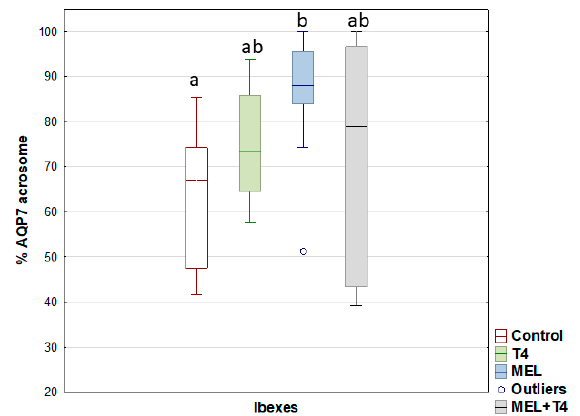
Figure 5. AQP7 expression by immunocytochemistry labelling (ICC) in acrosome of ibex sperm (controls (red); treated with thyroxine (T4, green); treated with melatonin implants (MEL, blue); and treated with melatonin implants plus thyroxine (MEL+T4, gray)). The boxes spread form the 1st to the 3rd quartiles. Box plots show the median (horizontal line) and spread from the 1st to the 3rd quartiles; the whiskers extend from the smallest to the largest value. Outliers are shown as circles. Different letters (a,b) between boxplots indicate significant differences ( p < 0.01).